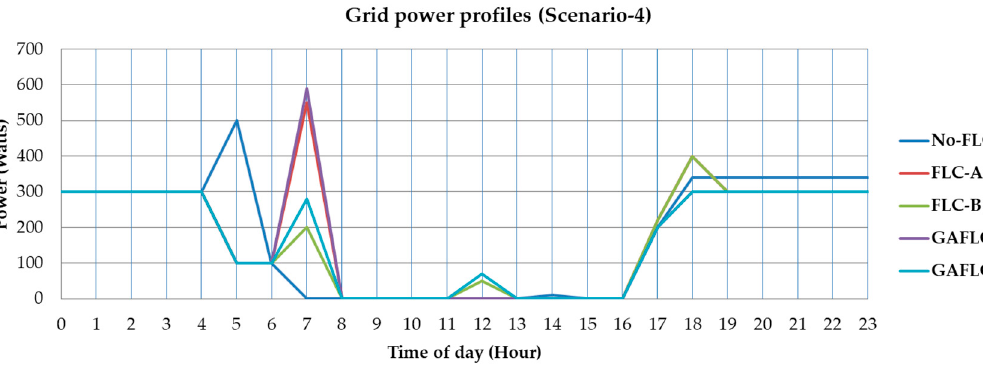
Figure 16. The grid power profiles in Scenario 4 (No-FLC, FLC-A, FLC-B, GAFLC-A, GAFLC-B).